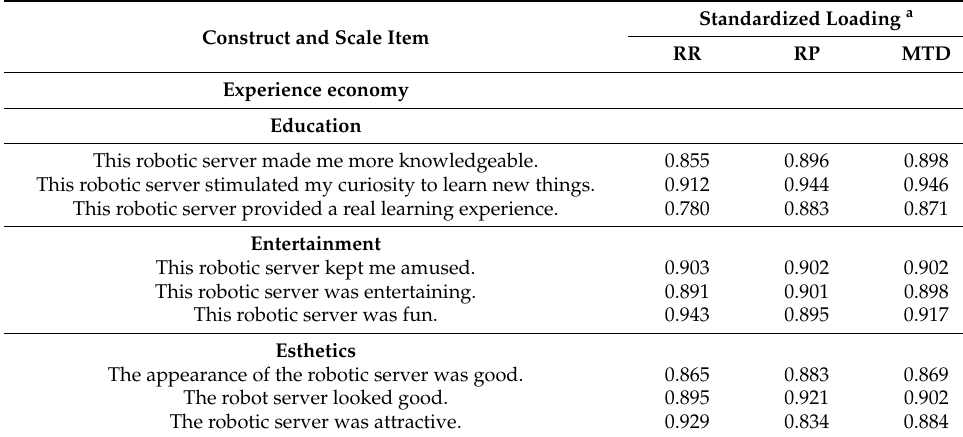
Table 2. Confirmatory factor analysis: items and